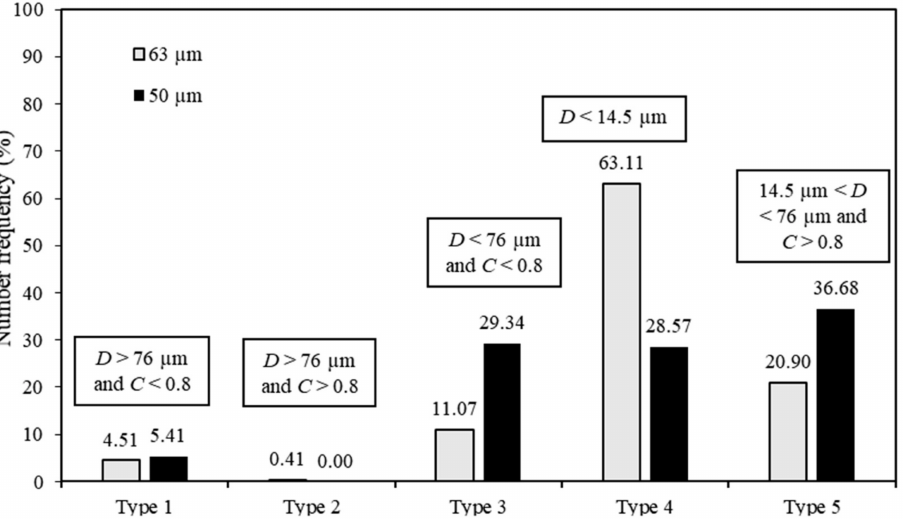
Figure 9. The number frequency of each type of powder particle present within the 63 µ m and 50 µ m sieve-captured Ti6Al4V